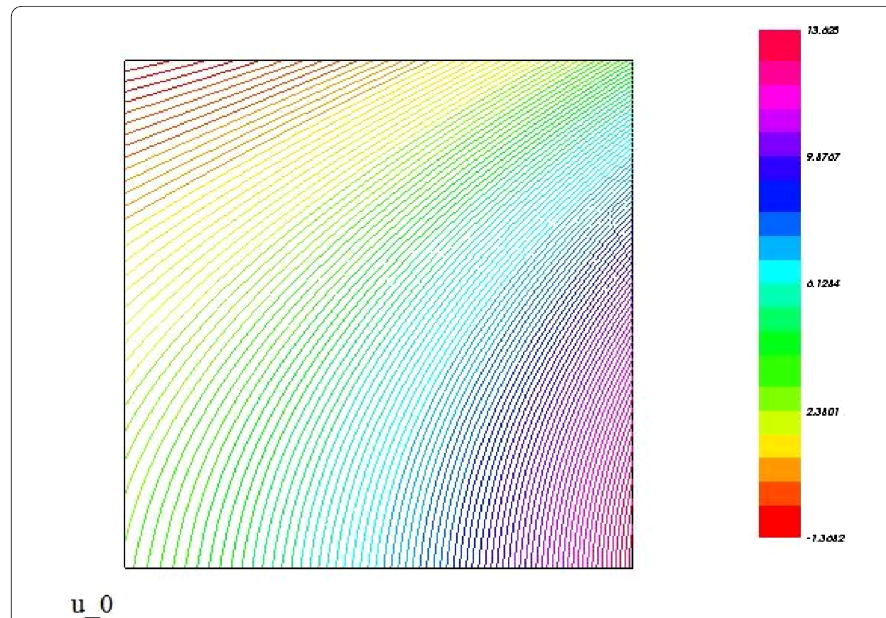
Figure 5 Isovalues of φ 0